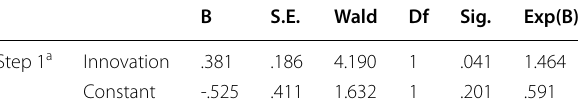
Table D: Variables in the equation for innovation culture